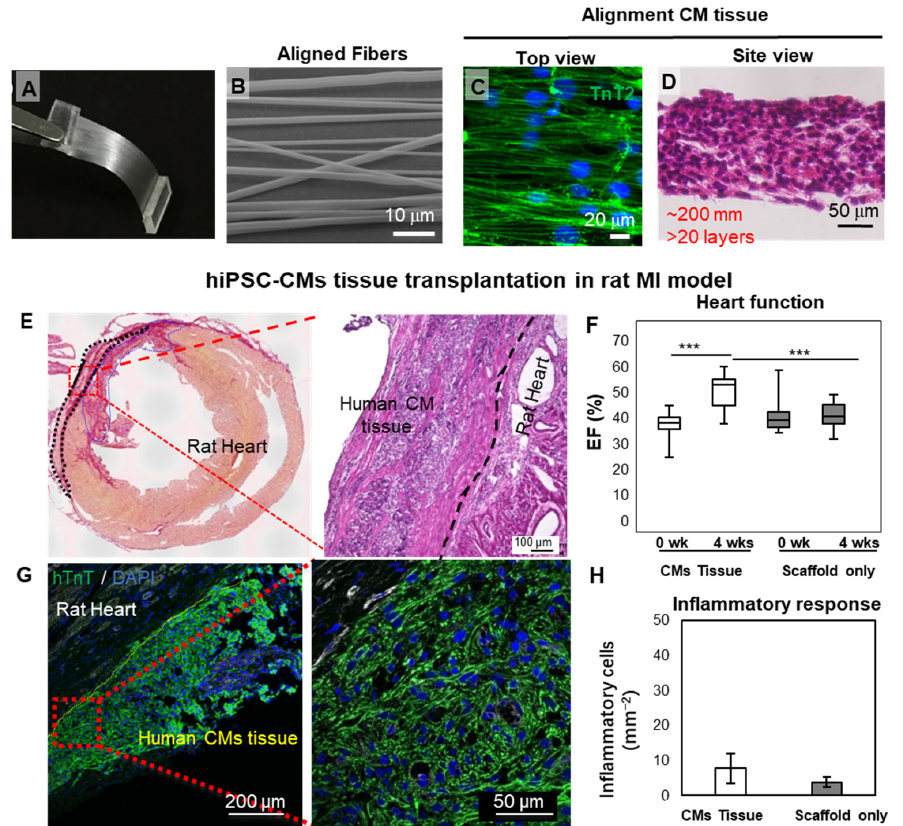
Figure 2. Cardiac-tissue-like constructs formed on aligned nanofibers. ( A – D ) Aligned PLGA fiber and the cardiac tissue obtained by seeding hiPSC-CMs. ( E – H ) Engraftment of cardiac tissue in an IM rat heart model. A large block of hiPSC-CMs could be found on the host heart four weeks after transplantation. (*** p < 0.001) Reprinted from Li et al. [48], with permission. Copyright 2017, the authors. PLGA, poly(lactic-co-glycolic acid); hiPSC-CMs, human induced pluripotent stem cell-derived cardiomyocytes; MI, myocardial infarction; EF, ejection fraction.